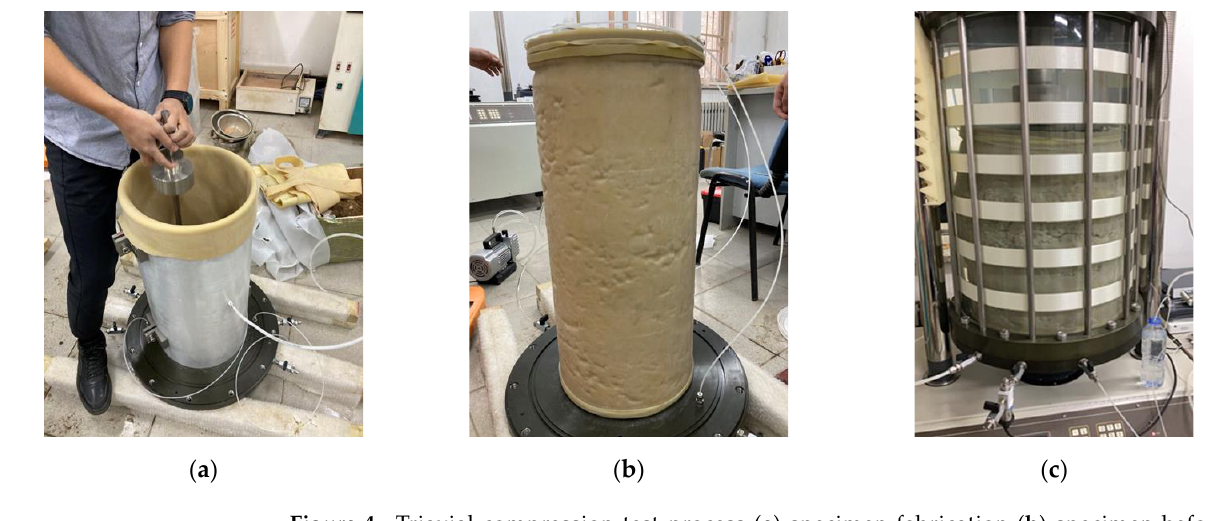
Figure 4. Triaxial compression test process ( a ) specimen fabrication ( b ) specimen before test ( c ) specimen after test.